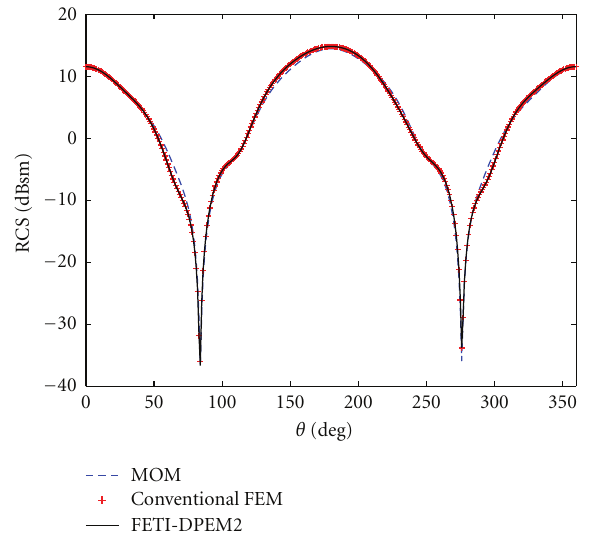
Figure 1: Bistatic RCS of the metallic cube with θ inc = 0 ◦ , ϕ inc = 0 ◦ at 0.3